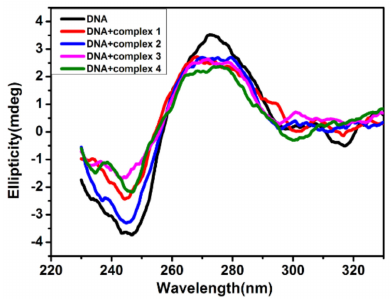
Figure 4. The circular dichroism spectra of CT-DNA (100 µ M) in the absence and presence of complexes 1 – 4 (3 µ